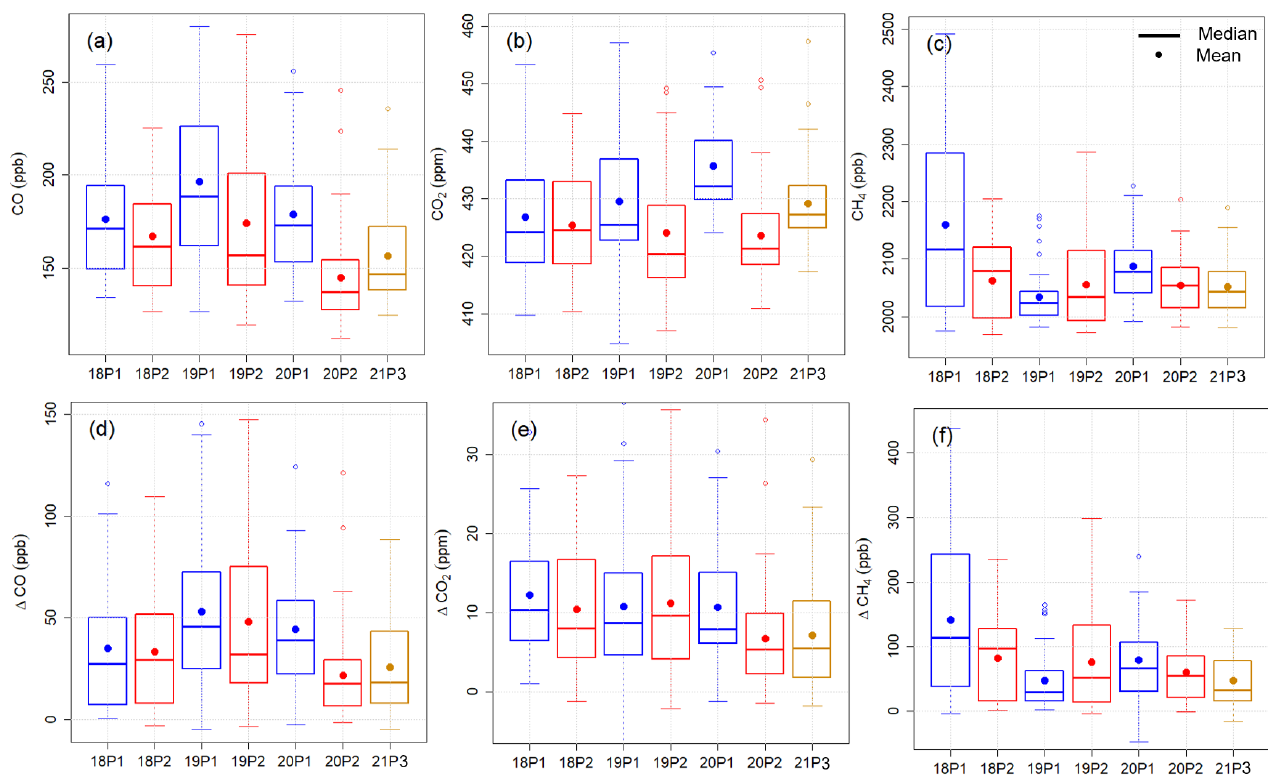
Figure 3. Box and whisker plots of daily 12:00 to 16:00 local time average dry-air mole fractions for ( a ) CO, ( b ) CO 2 , and ( c ) CH 4 , and enhancements above background for ( d ) CO, ( e ) CO 2 , and ( f ) CH 4 . Seven boxes are for the seven periods examined: “18P1” for 2018 Period 1, “18P2” for 2018 Period 2, etc. These periods are also color coded as blue for Period 1, red for Period 2, and brown for Period 3 in 2021. The description of the box and whisker plots is the same as for Figure